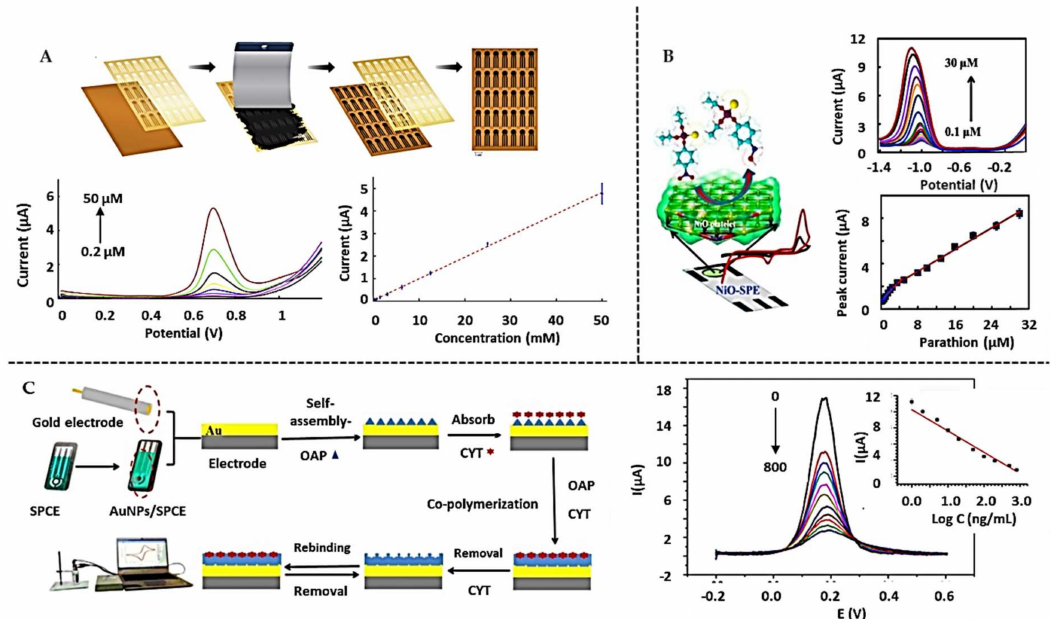
Figure 5. Direct detection-based biosensors for pesticides determination on screen-printed electrodes: ( A ) Scheme of the preparation of SPE for the determination of BTZN, SWV measurements and calibration curve. Reprinted from [157], Copyright 2019, with permission from Elsevier. ( B ) SPE modified with NiO NPs to determine Parathion, DPV signals and calibration curve. Reprinted from [160], Copyright 2018, with permission from Elsevier. ( C ) Use of MIP for the determination of CYT. Measurements by DPV and inset the calibration curve. Reprinted from [162], Copyright 2019, with permission from